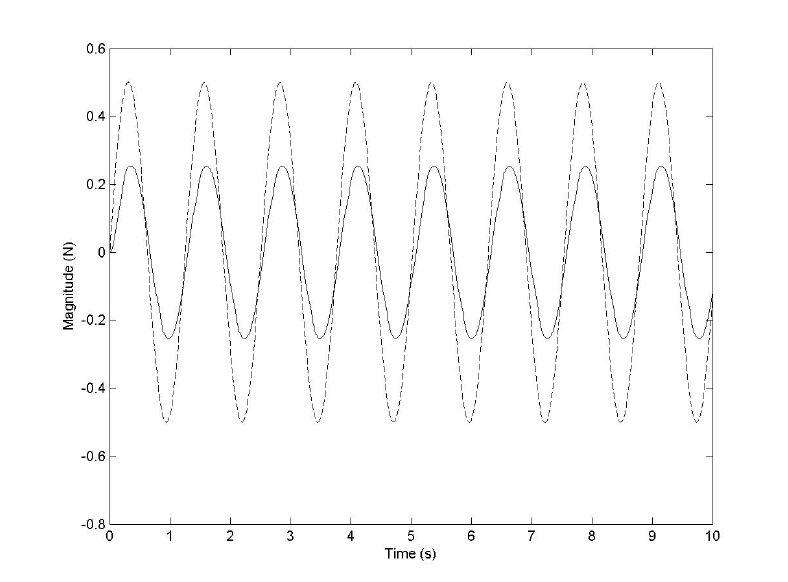
Fig. 17. Transmitted force variations of the system using the PD controller subjected to periodic engine disturbance at 1 Hz. Open loop (–) and PD controlled (solid). from 0.8 N to approximately 0.2 N. Which is approximately 75% transmitted force reduction. Even though, there